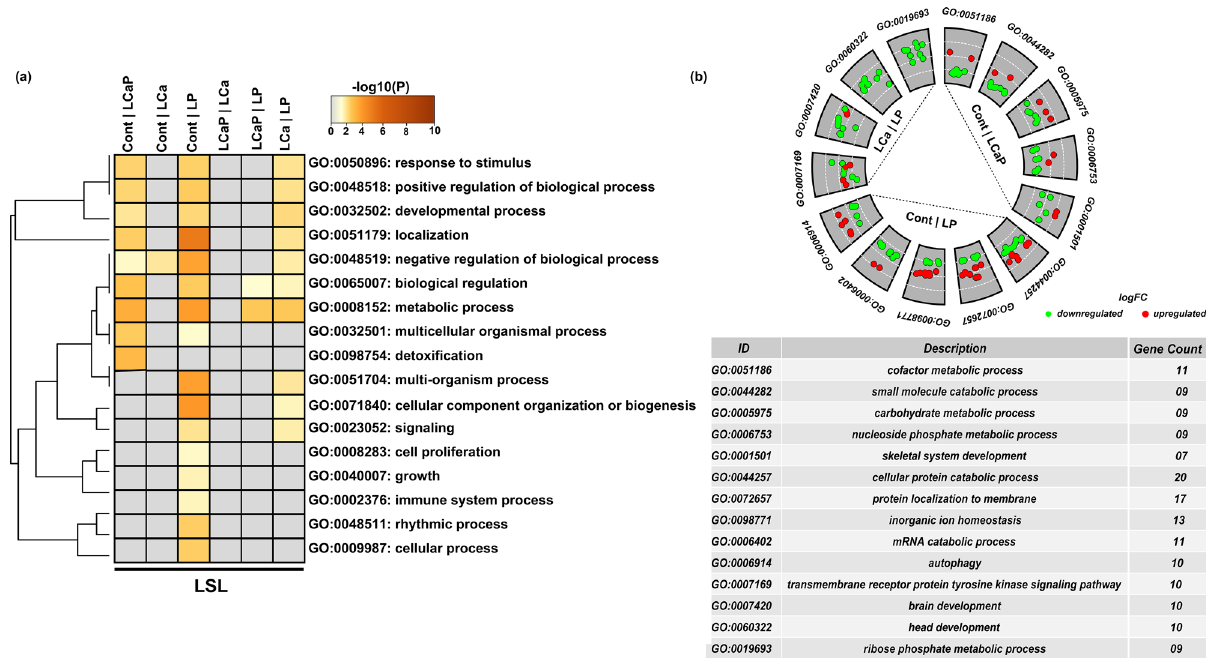
Figure 5. Gene ontology enrichment analysis of differentially expressed (DE) known miRNAs and their DE target genes from pairwise comparisons between diet groups within LSL strain. ( a ) Enrichment analysis of DE miRNAs and their target genes from different dietary comparisons was performed in Metascape. All statistically enriched biological processes with accumulative hypergeometric P values and enrichment score were identified. Significant biological terms were then hierarchically clustered into a tree based on Kappa-statistical similarities among their genes. Kappa score 0.3 was applied as threshold to cast the tree into biological term clusters. The heatmap cells are colored by their P values. Grey color indicates lack of enrichment and brown color indicates significant enrichment for that term in corresponding group gene list. (b) Go circular plot was generated by using Goplot (version.1.0.2) (https:// CRAN.R- proje ct. org/ packa ge= GOplot) within R programming environment (https:// www.R- proje ct. org/). Only the dietary comparison groups, which indicated the significant enrichment, were selected. Top five biological processes were selected from these enriched groups based on number of genes involved in a biological process. White dotted line indicates the partition of logFC from low to high